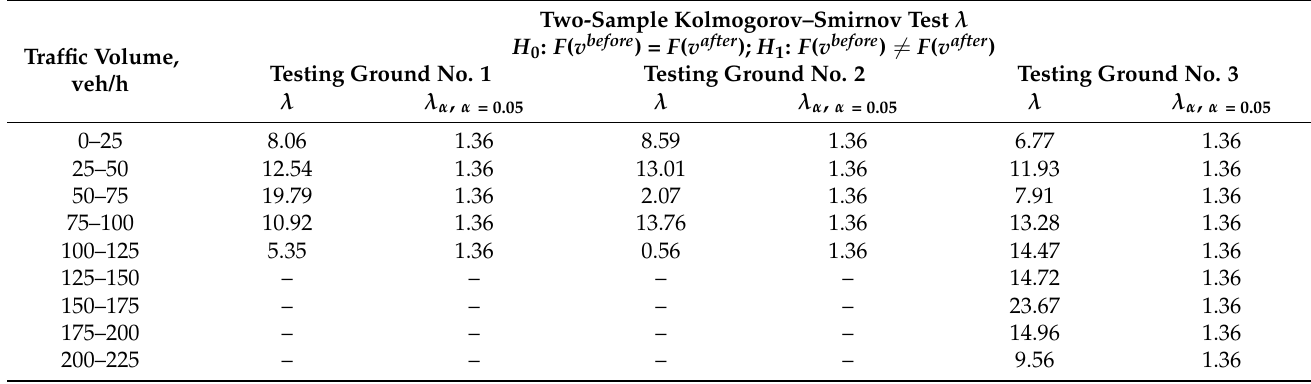
Table A2. Results of two-sample Kolmogorov–Smirnov